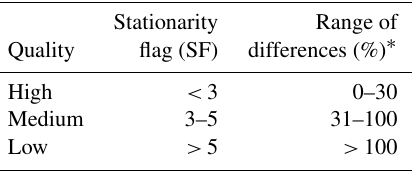
Table 1. Quality flag categories based on the stationarity rating of the eddy-covariance flux data. The definition of quality categories follows the scheme proposed by Sabbatini et al. (2018), which is based on stationarity tests developed by Foken et al. (2004, 2012) but uses stricter thresholds to separate